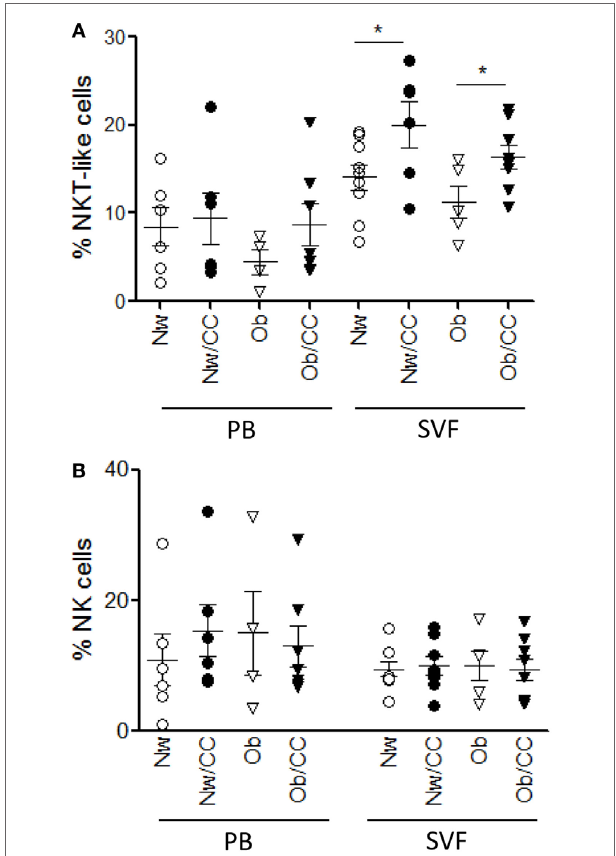
FigUre 4 | The frequency of visceral adipose tissue (VAT)-associated NKT cells, but not NK cells, is increased in colorectal cancer (CRC)-affected subjects as compared to cancer-free donors. VAT stromal vascular fraction (SVF) and peripheral blood (PB) lymphocytes isolated from lean normal weight (Nw), obese (Ob), lean affected by CRC (Nw/CC), and Ob affected by CRC (Ob/CC) donors were analyzed by flow cytometry. Frequencies of NKT (CD3 + CD56 + ) (a) and NK (CD3 − CD56 + ) (B) cells were evaluated in the four categories of donors. Each dot represents an individual donor. Mean ± SEM is shown for each group. * p < 0.05, by analysis of